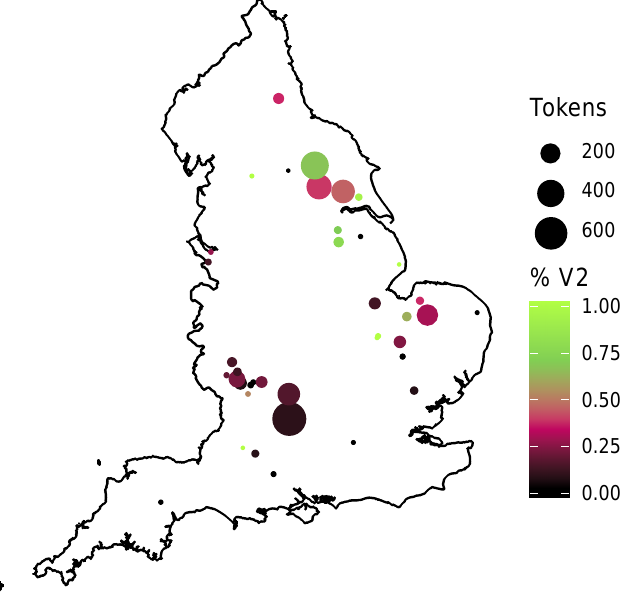
Figure 3. Rate of inversion in nonsubject‑initial sentences with pronominal subjects, all PLAEME